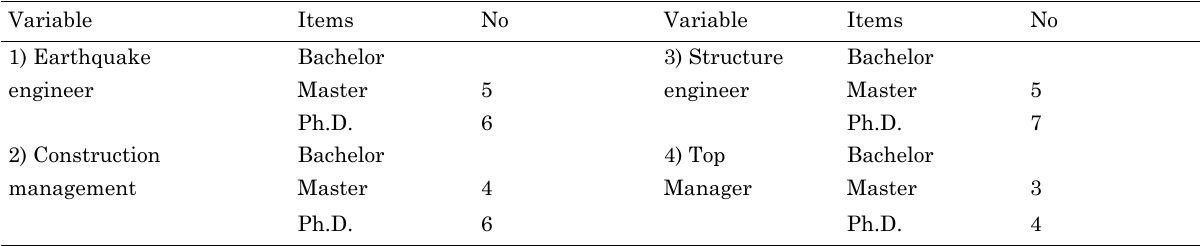
Table 1. Background information of